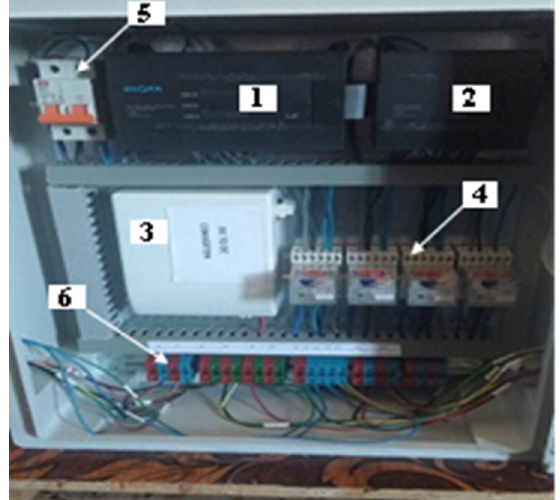
Fig. 4. Control system: 1-PLC, 2-A/D converter, 3- DC/DC converter, system 4-relays, 5-main switch,